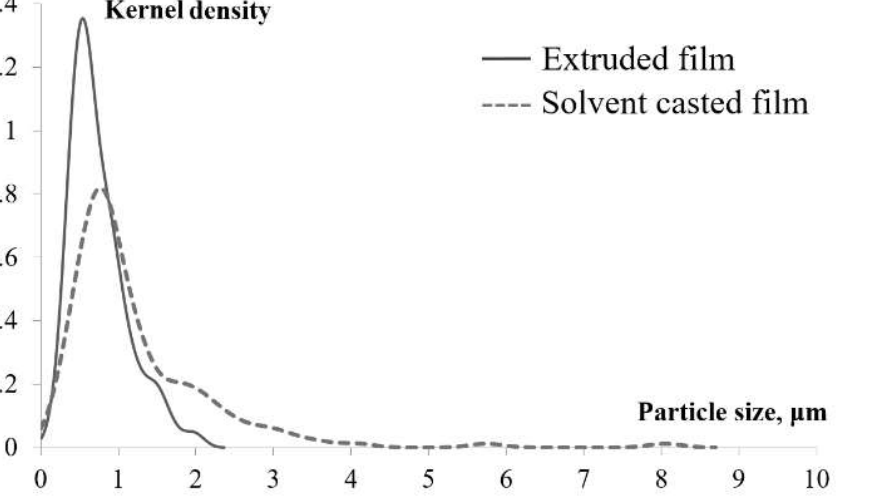
Table 2. The main characteristics of the POM/PLA composite films.